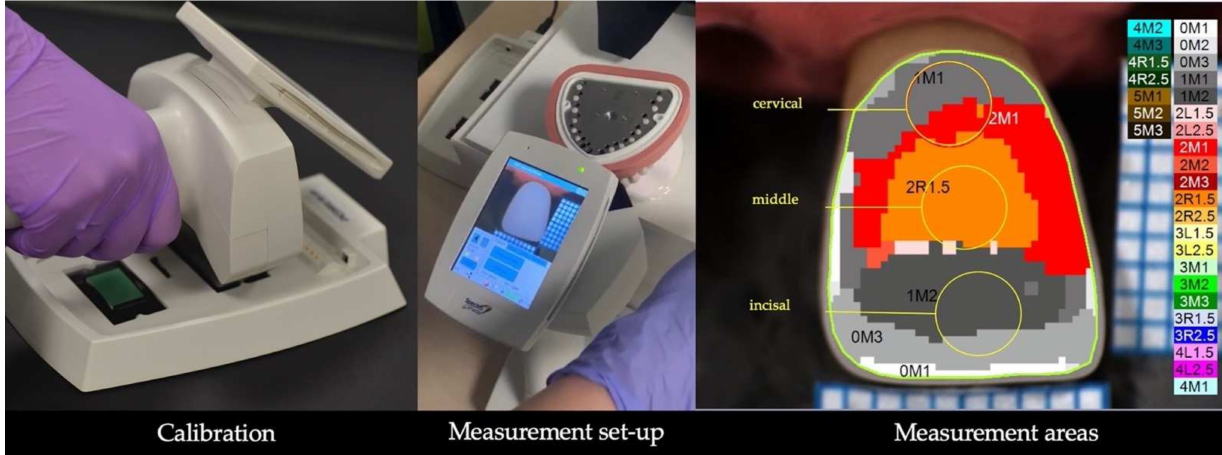
Figure 4. The measurement set-up for the dental spectrophotometer and the data